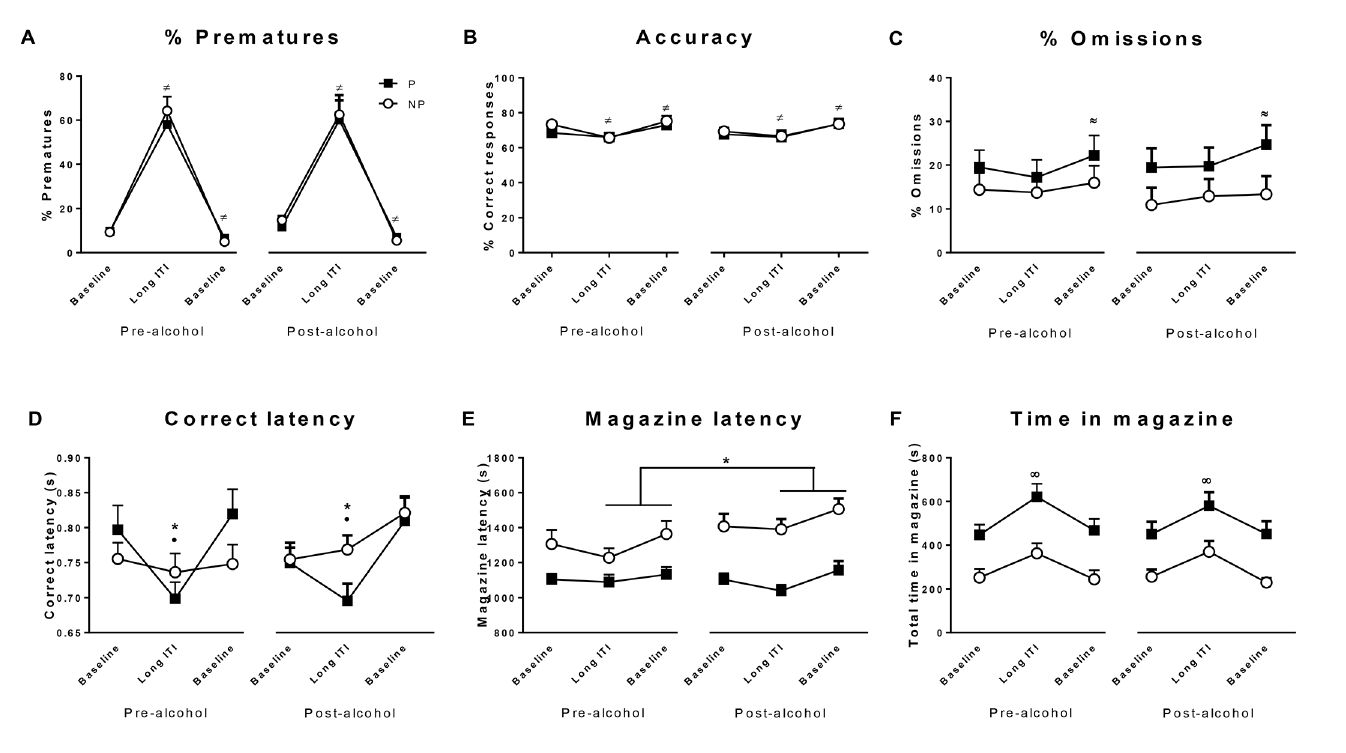
Fig 1. 5-CSRTT. Performance of alcohol-preferring rats (P, closed squares) and alcohol-non-preferring rats (NP, open circles) in the 5-CSRTT, during baseline sessions (ITI = 5s) and during the long ITI challenge session (ITI = 7s) before and after the 4-week alcohol intake. Data are means ± SE of % premature responding (a), attentional accuracy (b), % omissions (c), correct response latency (d), food magazine latency (e) and time spend nose-poking in the food magazine (f). All p < 0.05: ( 6¼ ) vs baseline A, ( σ ) vs previous sessions; ( * ) significant difference between P and NP rats in the same session; ( (cid:129) ) vs baseline A in P rats, ( 1 ) vs baseline A and B; (x) versus pre-alcohol sessions in NP rats.